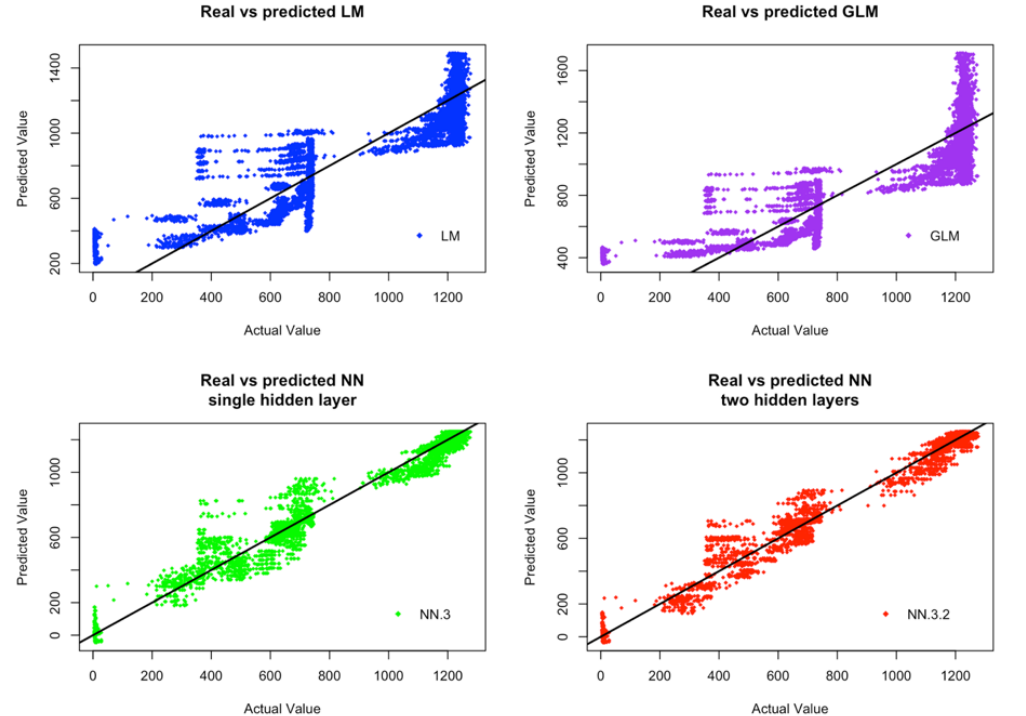
Figure 4. Plots of the actual values against predicted values of numbers of CCDs at the simulation end for the four considered models..